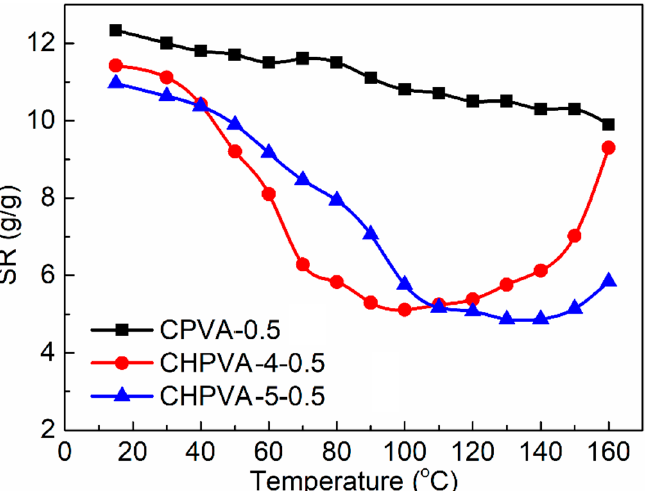
Figure 8. Swelling ratio vs. solution temperature for hydrogels with different HPM/PVA molar ratios (indicated in the figure) at the same crosslinker concentration in saline (0.5 wt% of GA). At a temperature lower than 60 °C, which approximates to the LCST of the hydrophobic-modi fi ed PVA hydrogels, both CHPVA-4-0.5 and CHPVA-5-0.5 hydrogels have relatively high swelling ratio. Comparatively, in the range of 60~120 °C which is